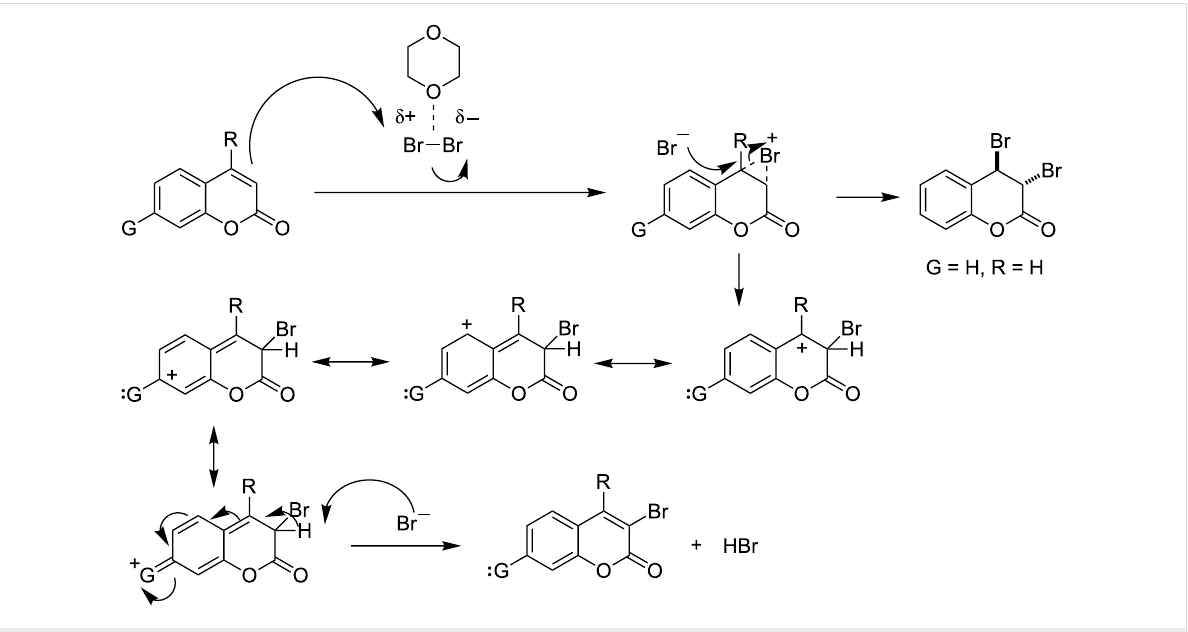
Figure 1: Mechanism for bromination of the heterocyclic